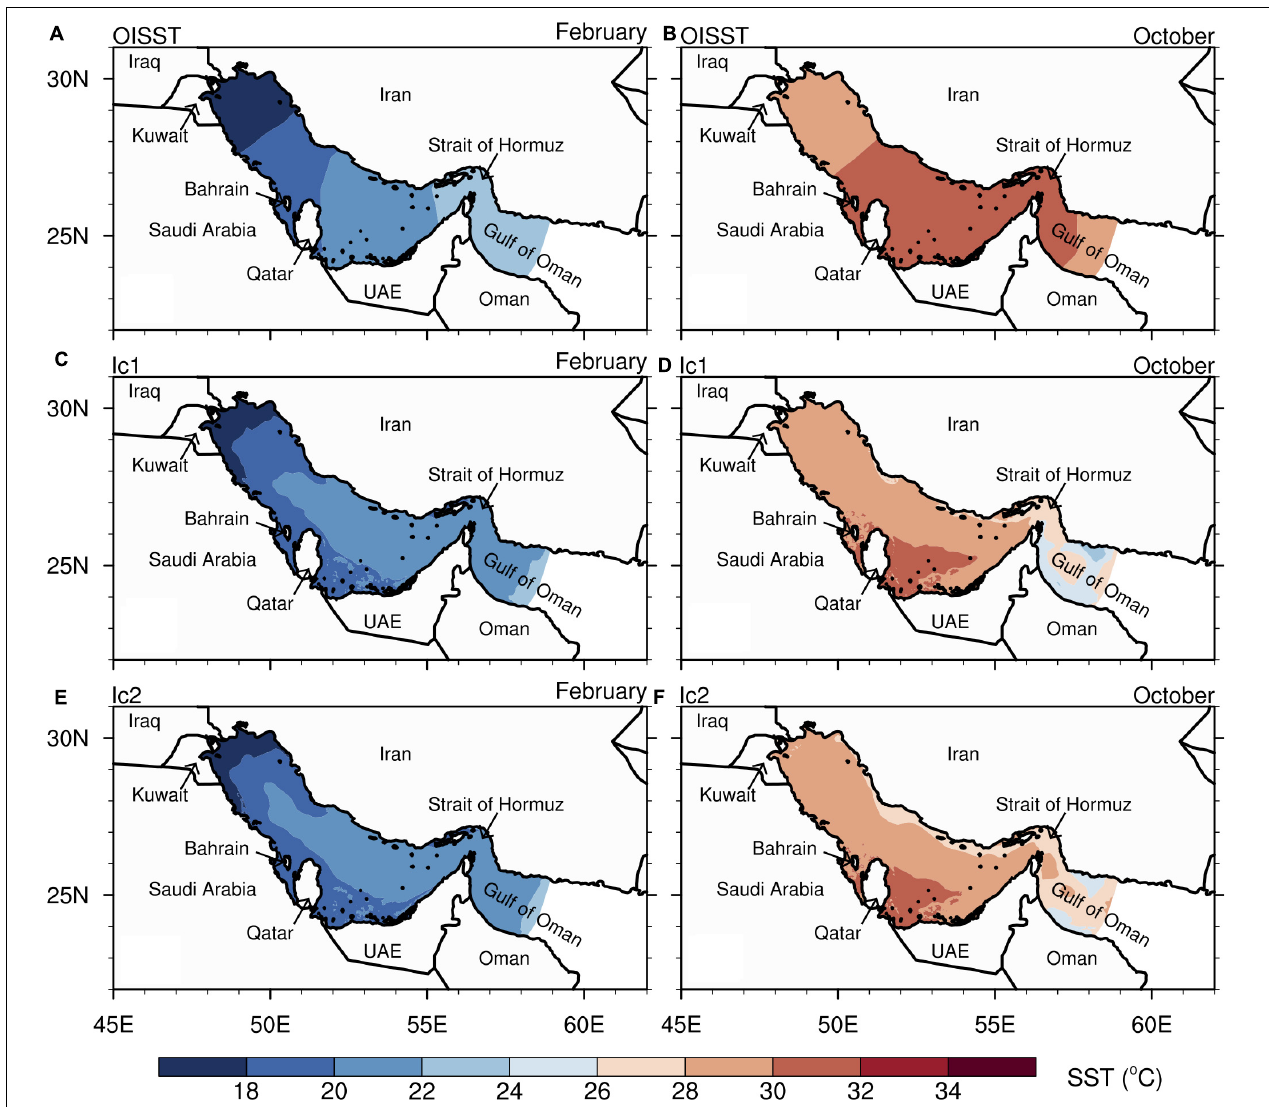
FIGURE 4 | Simulated climatological (1981–1990) sea-surface temperature (SST) in February and October compared to analysis SST (OISST). (A,B) OISST. (C,D) Ic1experiment. (E,F) Ic2